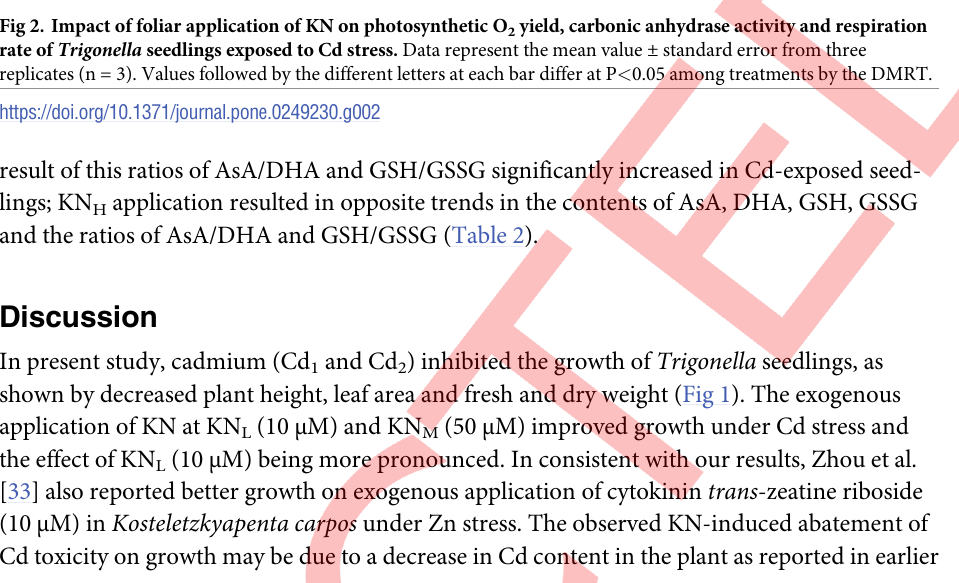
Fig 2. Impact of foliar application of KN on photosynthetic O 2 yield, carbonic anhydrase activity and respiration rate of Trigonella seedlings exposed to Cd stress. Data represent the mean value ± standard error from three replicates (n = 3). Values followed by the different letters at each bar differ at P < 0.05 among treatments by the DMRT.